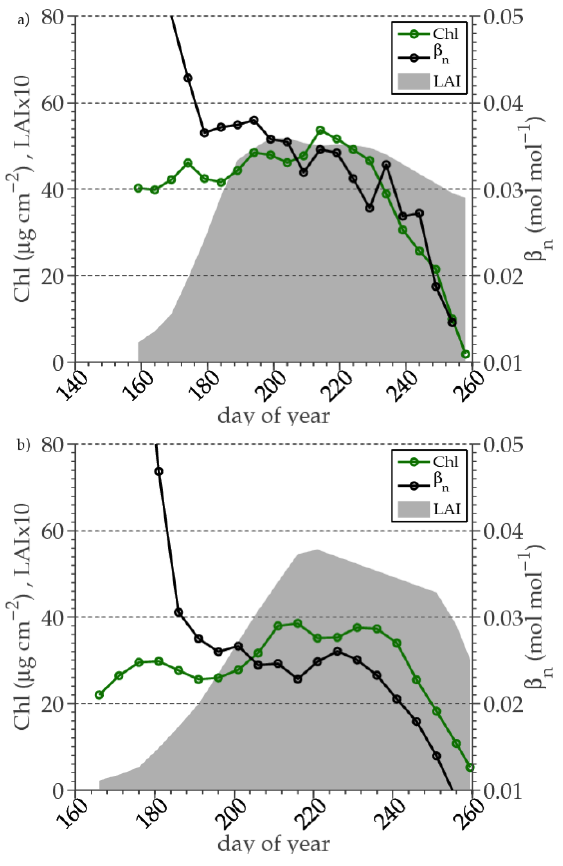
Figure 3. Seasonal trends of β n , leaf Chl, and LAI for (a) an irri- gated maize field (field 1, 2005) and (b) an irrigated soybean field (field 2, 2002).